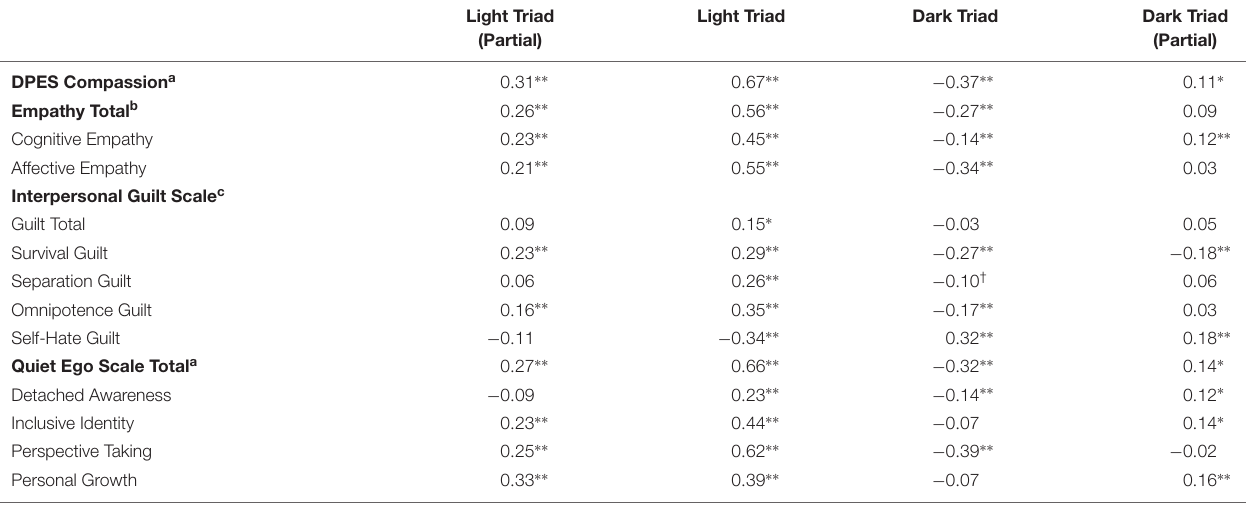
Light Triad Light Triad Dark Triad Dark Triad (Partial)